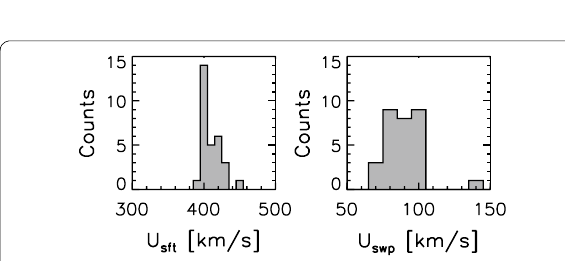
Fig. 6 Histogram of shift velocity and sweeping velocity obtained from the spectral moment